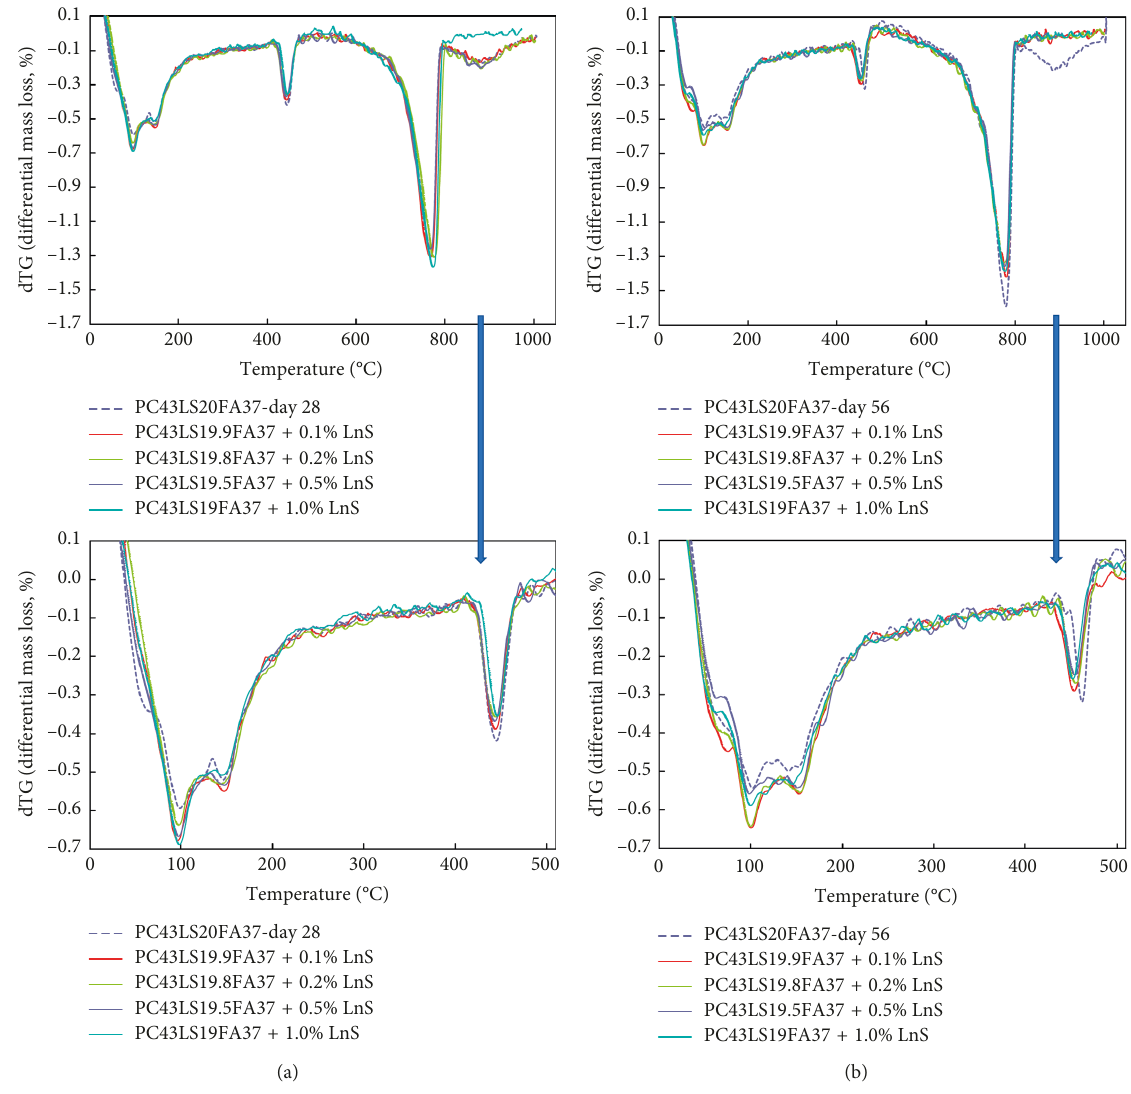
Figure 11: Differential mass loss of LnS nanocomposite binders based on PC43LS20FA37 (a) at day 28 and (b) at day